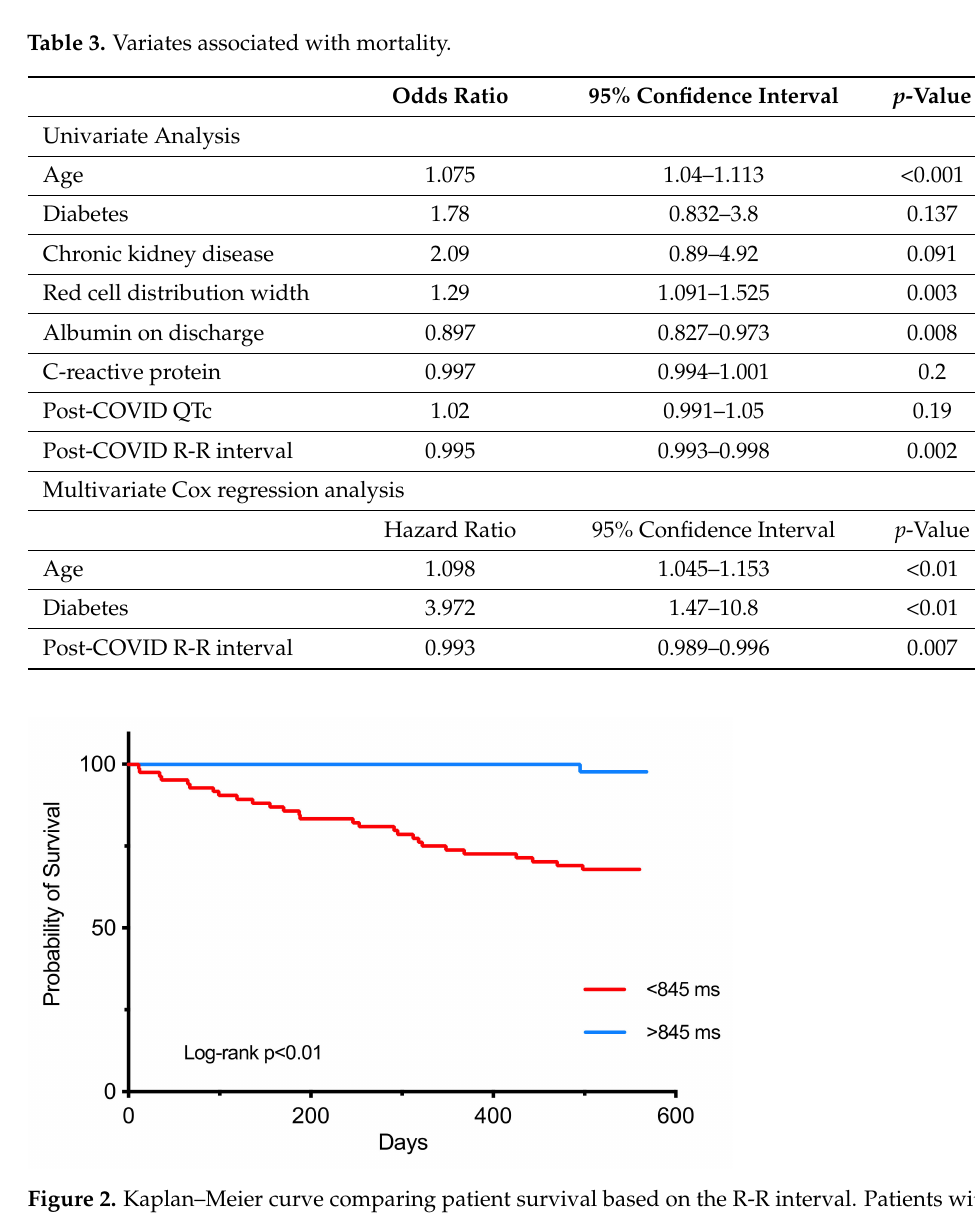
Figure 2. Kaplan–Meier curve comparing patient survival based on the R-R interval. Patients with a resting R-R interval of >845 ms were more likely to die in comparison to patients with an R-R interval of <845 ms (HR 4.5 [2.1–9.6], p <